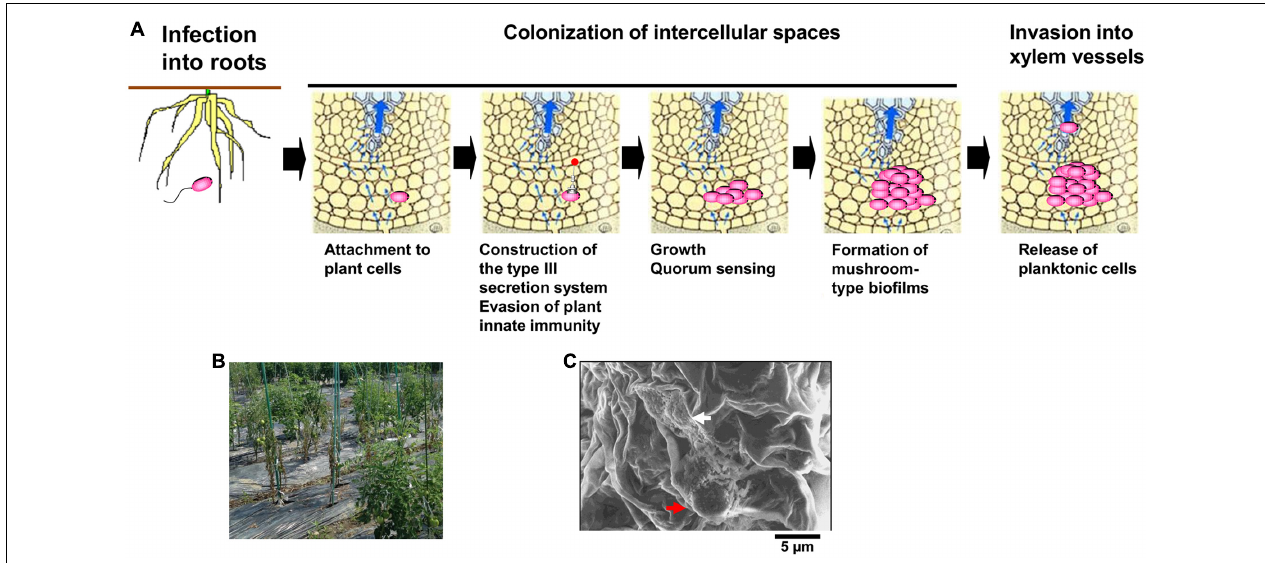
FIGURE 1 | Infection route of Ralstonia solanacearum in intercellular spaces of roots (A) , bacterial wilt of tomato plants caused by R. solanacearum in a field located in Kochi university, Japan (B) , and microcolony (white-colored arrow) and the mushroom type-biofilm formed by cells of R. solanacearum strain OE1-1 (red-colored arrow) on tomato cells observed by the scanning electron microscope (C)